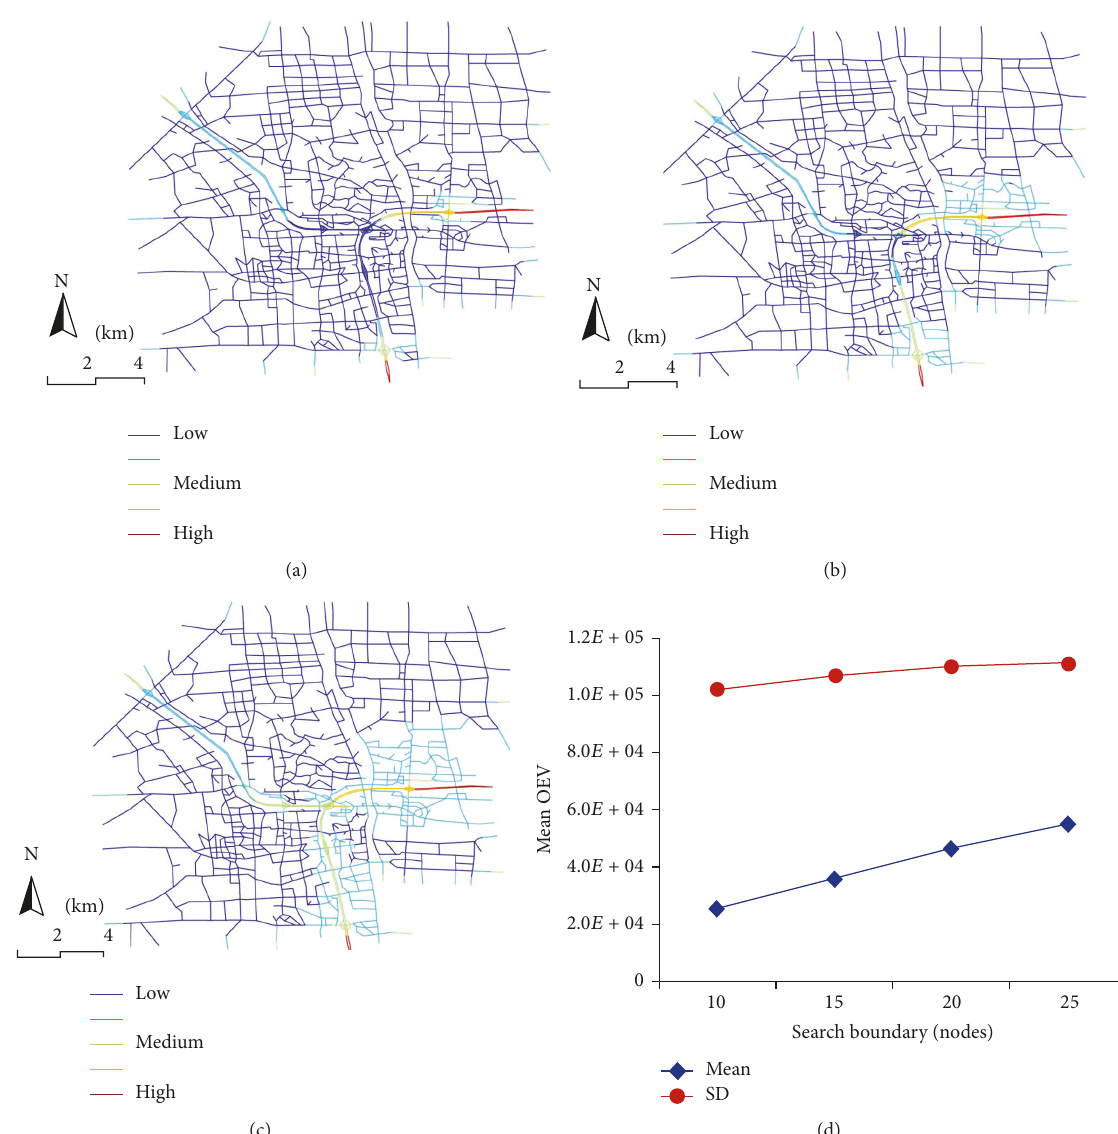
Figure 5: The OEV under different search boundaries: (a) 10 nodes; (b) 15 nodes; (c) 25 nodes; (d) the mean value and SD of all lines by search